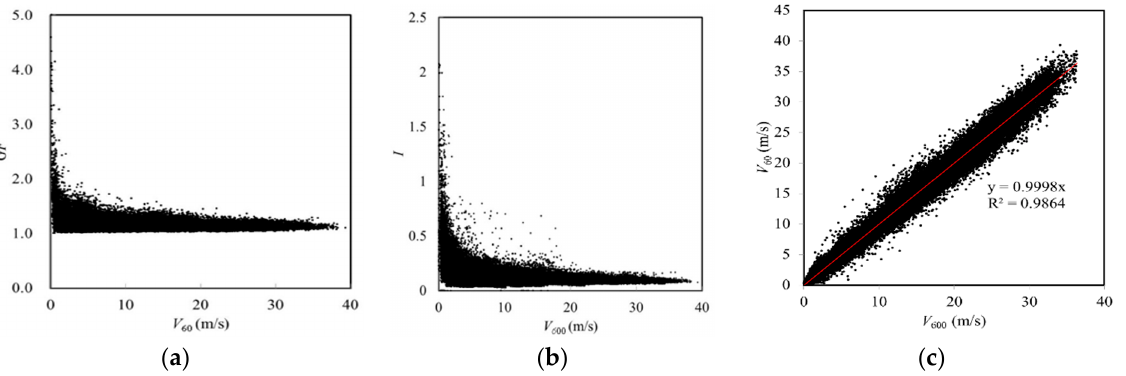
Figure 4. Wind measurements. ( a ) Gust factor; ( b ) turbulence intensity; ( c ) wind speed correlation.